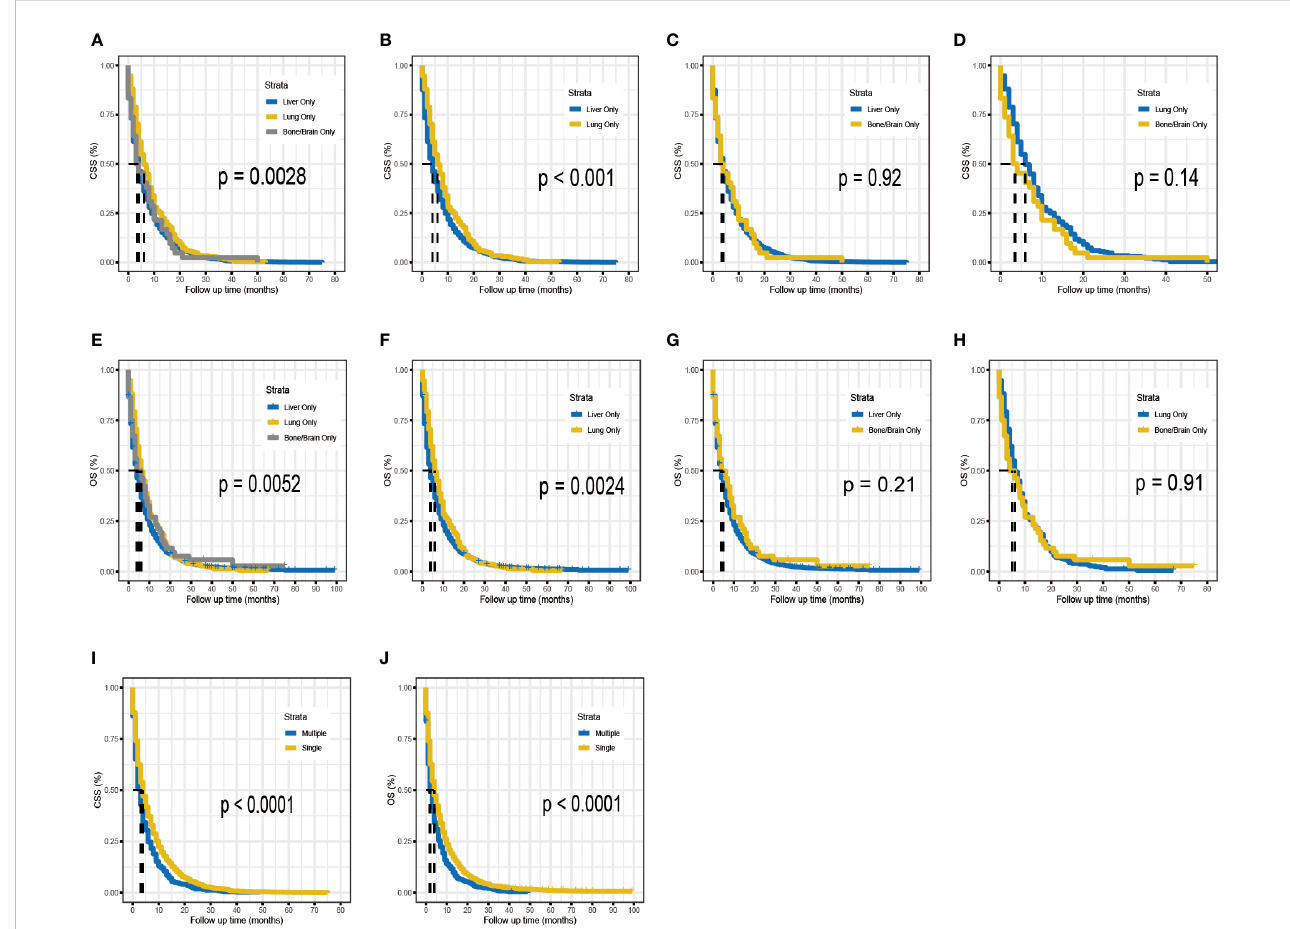
FIGURE 1 Kaplan – Meier analysis for CSS (A – D) and OS (E – H) of metastatic PDAC according to the metastatic site. Kaplan – Meier analysis for CSS (I) and OS (J) of metastatic PDAC according to the number of distant